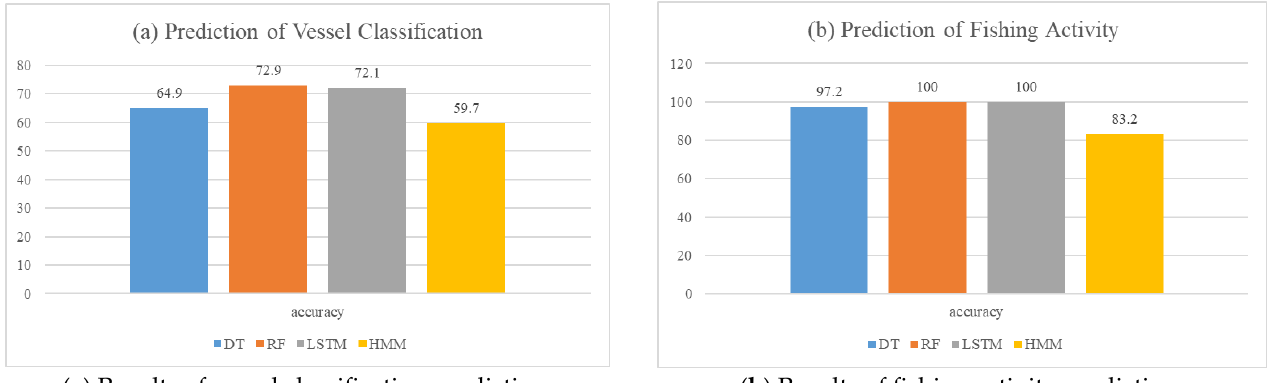
Figure 15. Procedures of Fishing Activity and Ship Type Prediction. ( a ) Selection models phase; ( b ) Training model phase; ( c ) Test models phase; ( d ) Inferences.